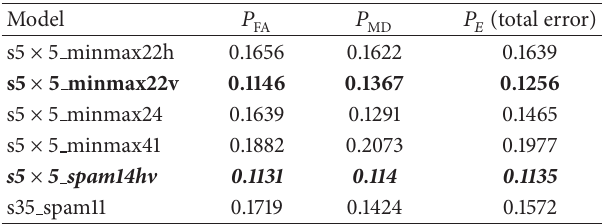
Table 5: Detection results of the EDGE5 × 5 submodels and the square submodel.